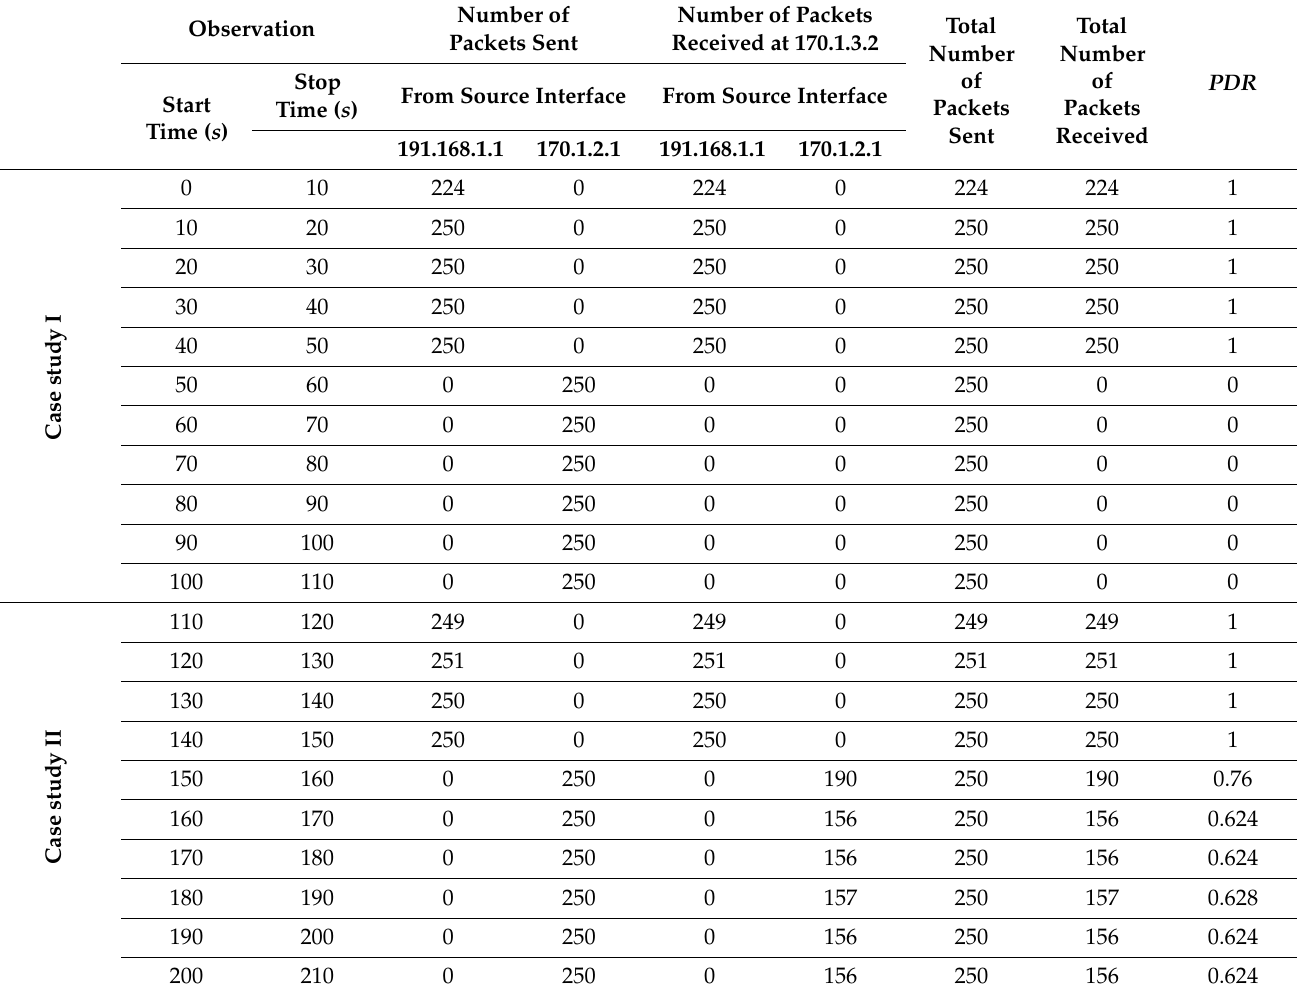
Table 3. NS-3 simulation results for the SCN based on the graph-theoretic